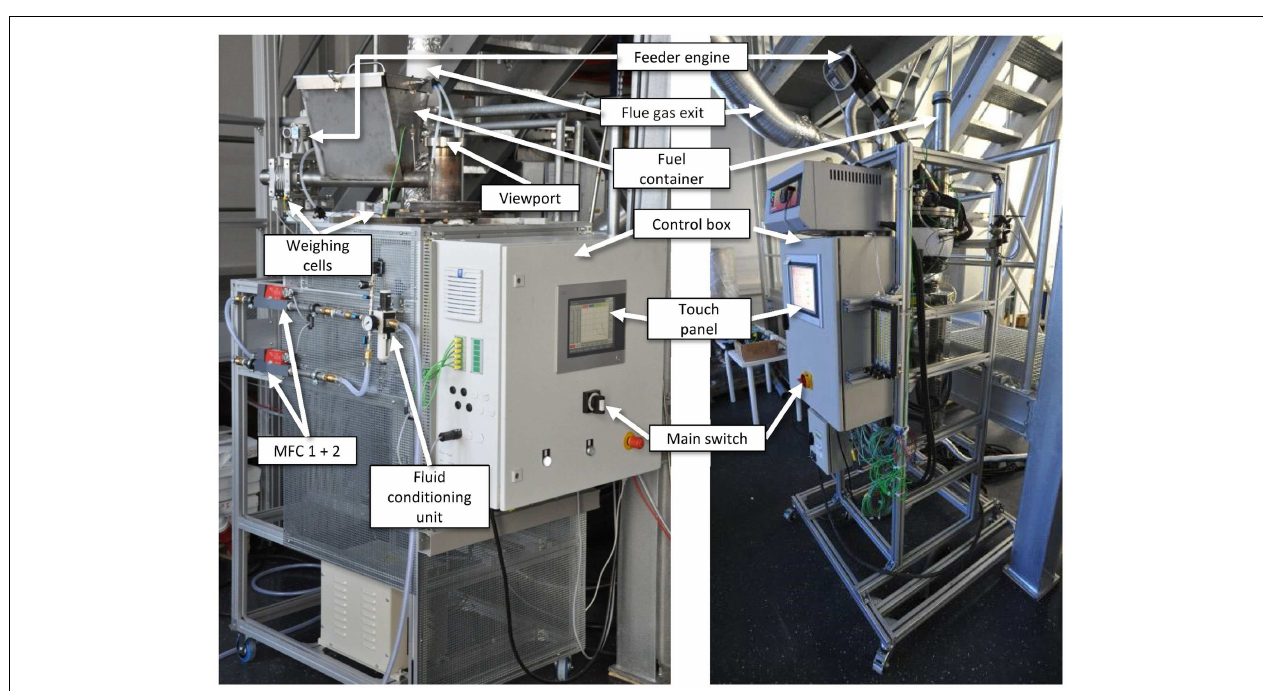
FIGURE 2 | L.A.P.I.S. reactors in operational condition (V2 on the left,V1 on the right) .